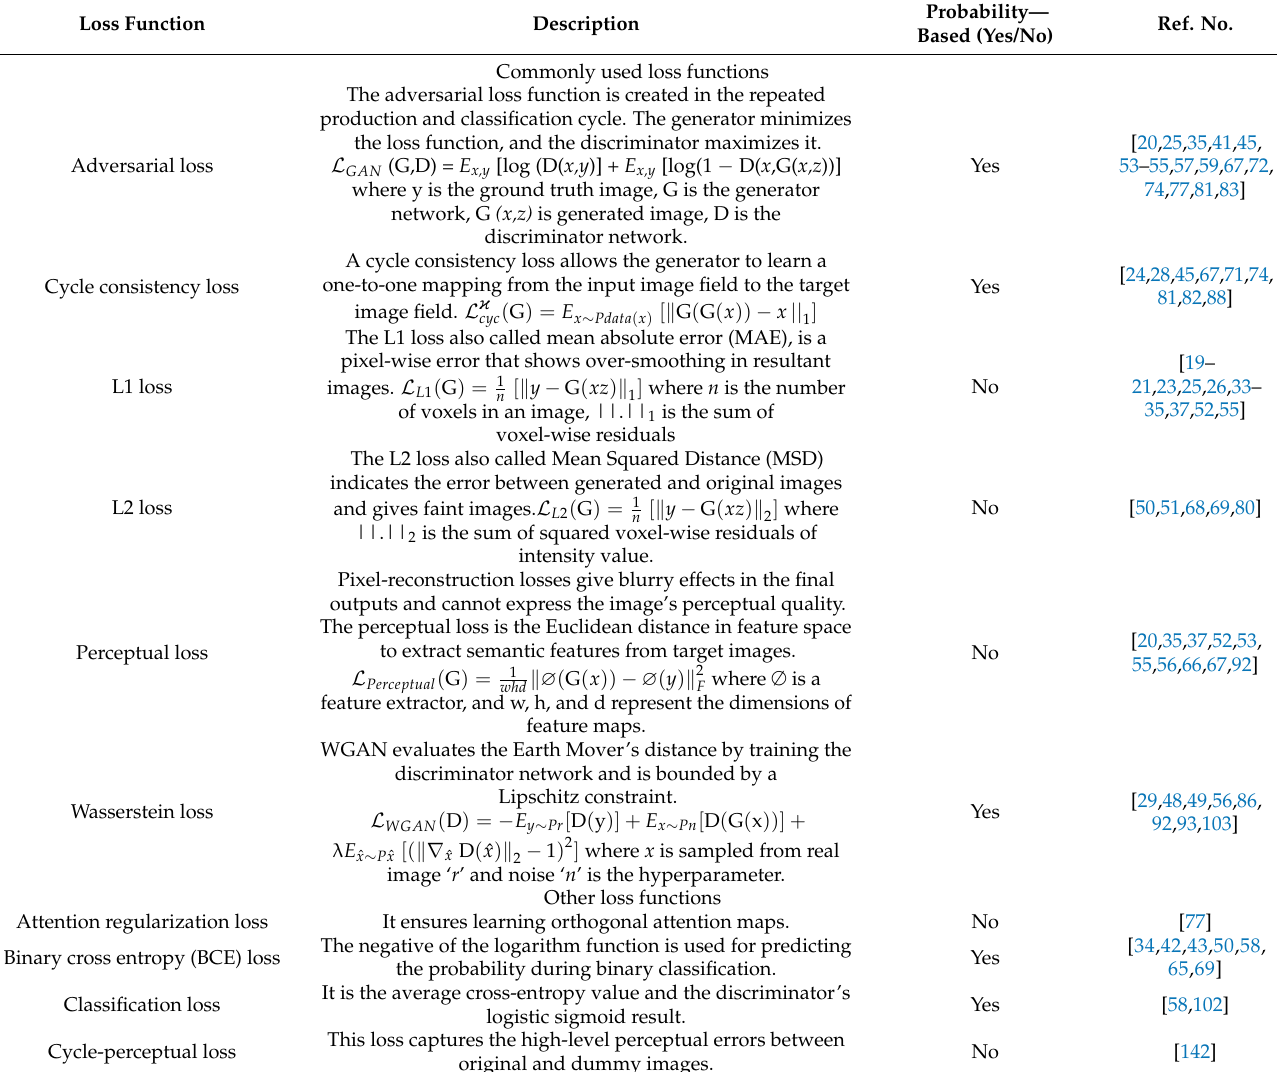
Table 8. Summary of loss functions used in applications of GAN-synthesized brain MRI.